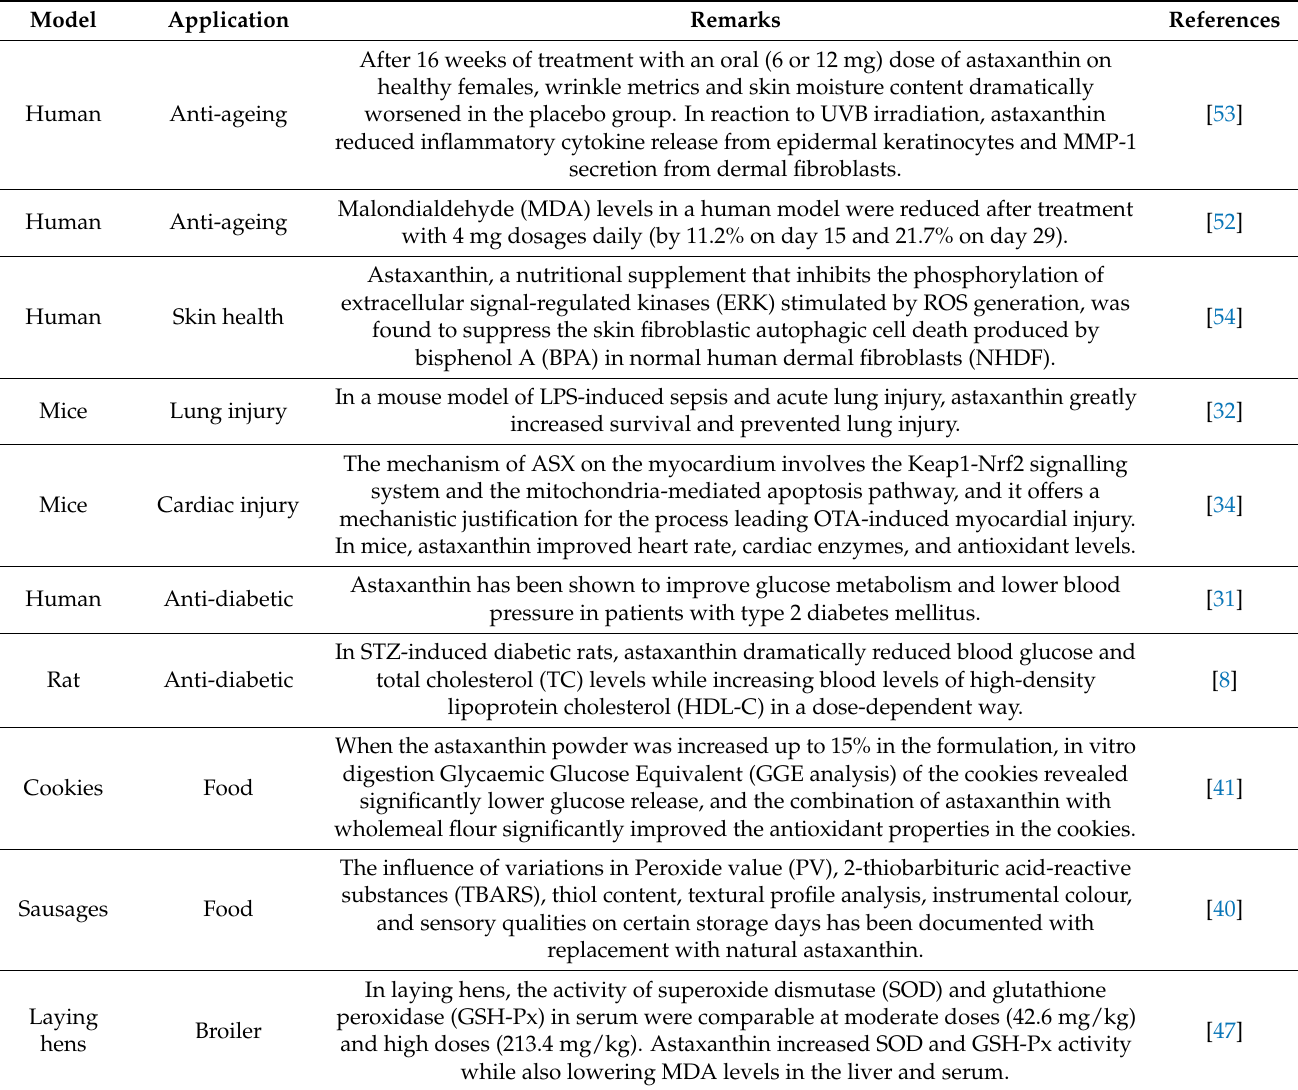
Table 1. Summarised recent research associated with astaxanthin consumption in different application. Model